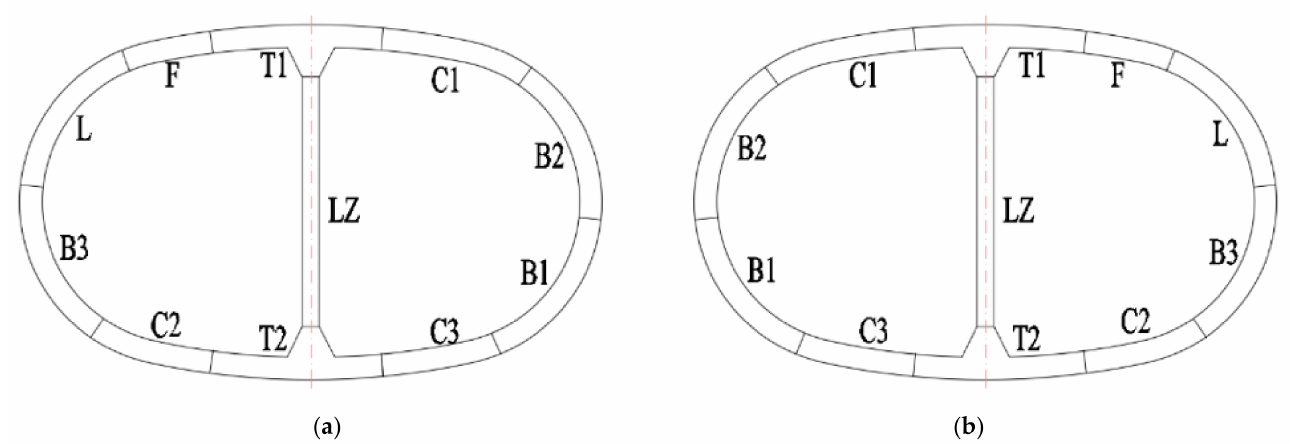
Figure 2. Segmentation diagram of segment. ( a ) (ZR1) segment; ( b ) (ZR2)